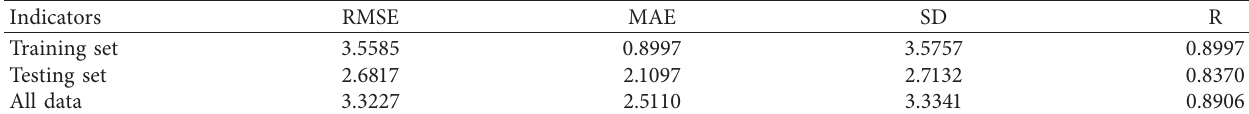
Figure 8: Regression analysis of RF with respect to (a) training dataset, (b) testing dataset, and (c) all dataset. Table 3: Summary of prediction results of the RF model in terms of RMSE, MAE, and R